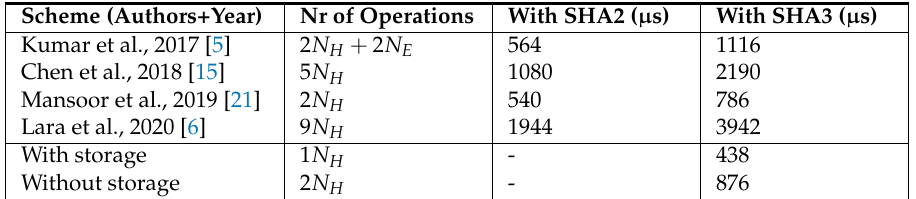
Table 3. Comparison of computational cost with related and recent literature. N H equals the number of hashes and N e the number of encryption operations.